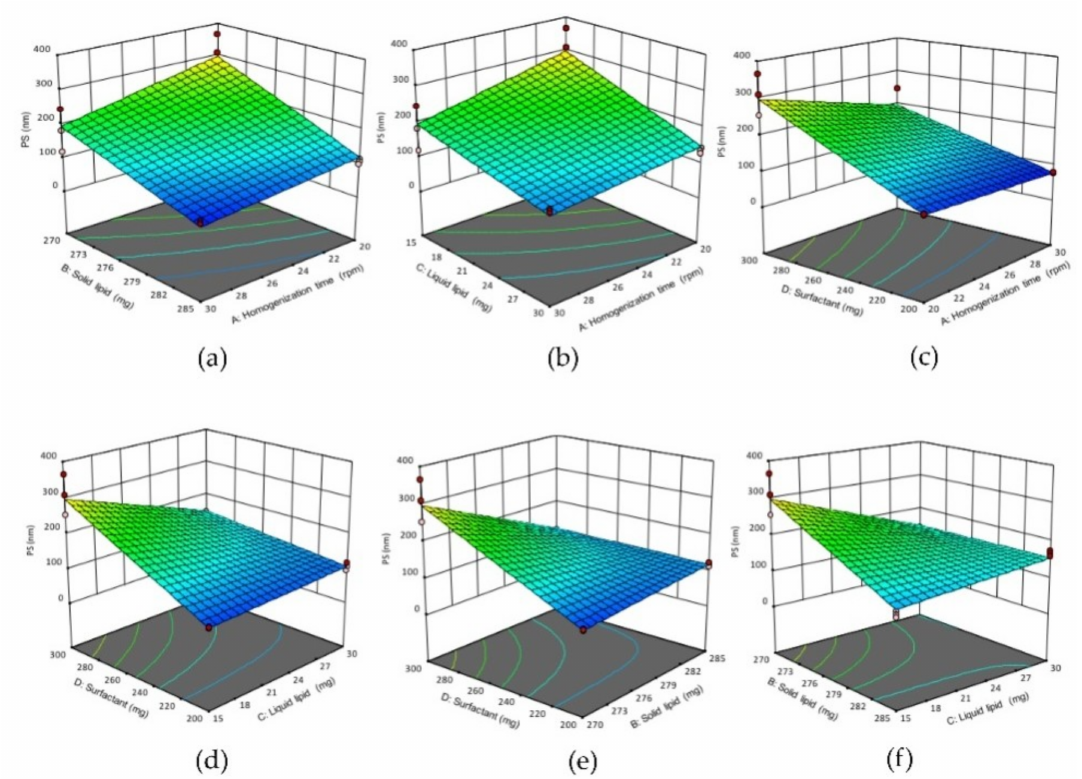
Figure 1. 3D response surface plots showing the effect of interactions ( a ) AB, ( b ) AC, ( c ) AD, ( d ) CD, ( e ) BD and ( f ) BC on the PS of NLCs. ( A ) Homogenization time, ( B ) solid lipid concentration, ( C ) liquid lipid concentration, ( D ) surfactant